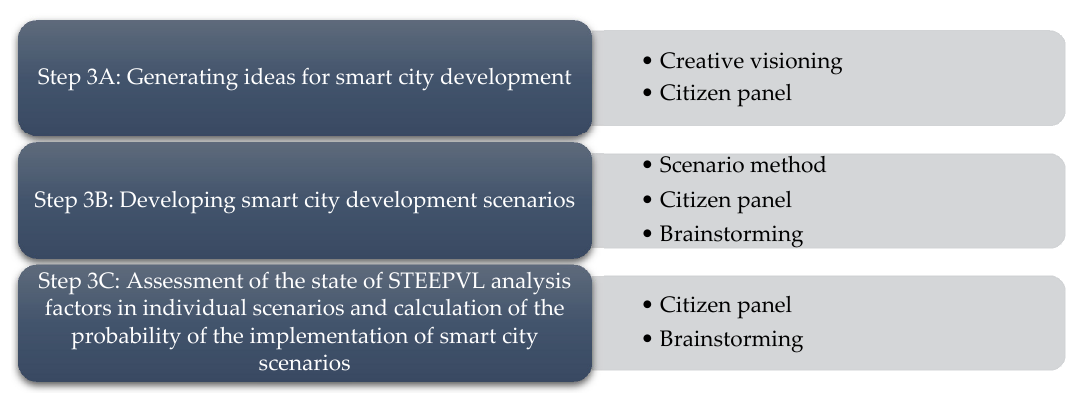
Figure 6. Operationalisation scheme for Stage 3 of the research process.